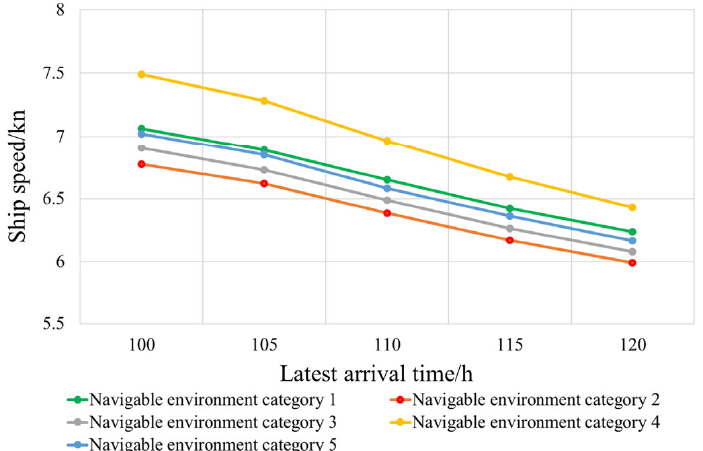
Figure 13. Optimal speeds for different environmental categories under different latest arrival time constraints.